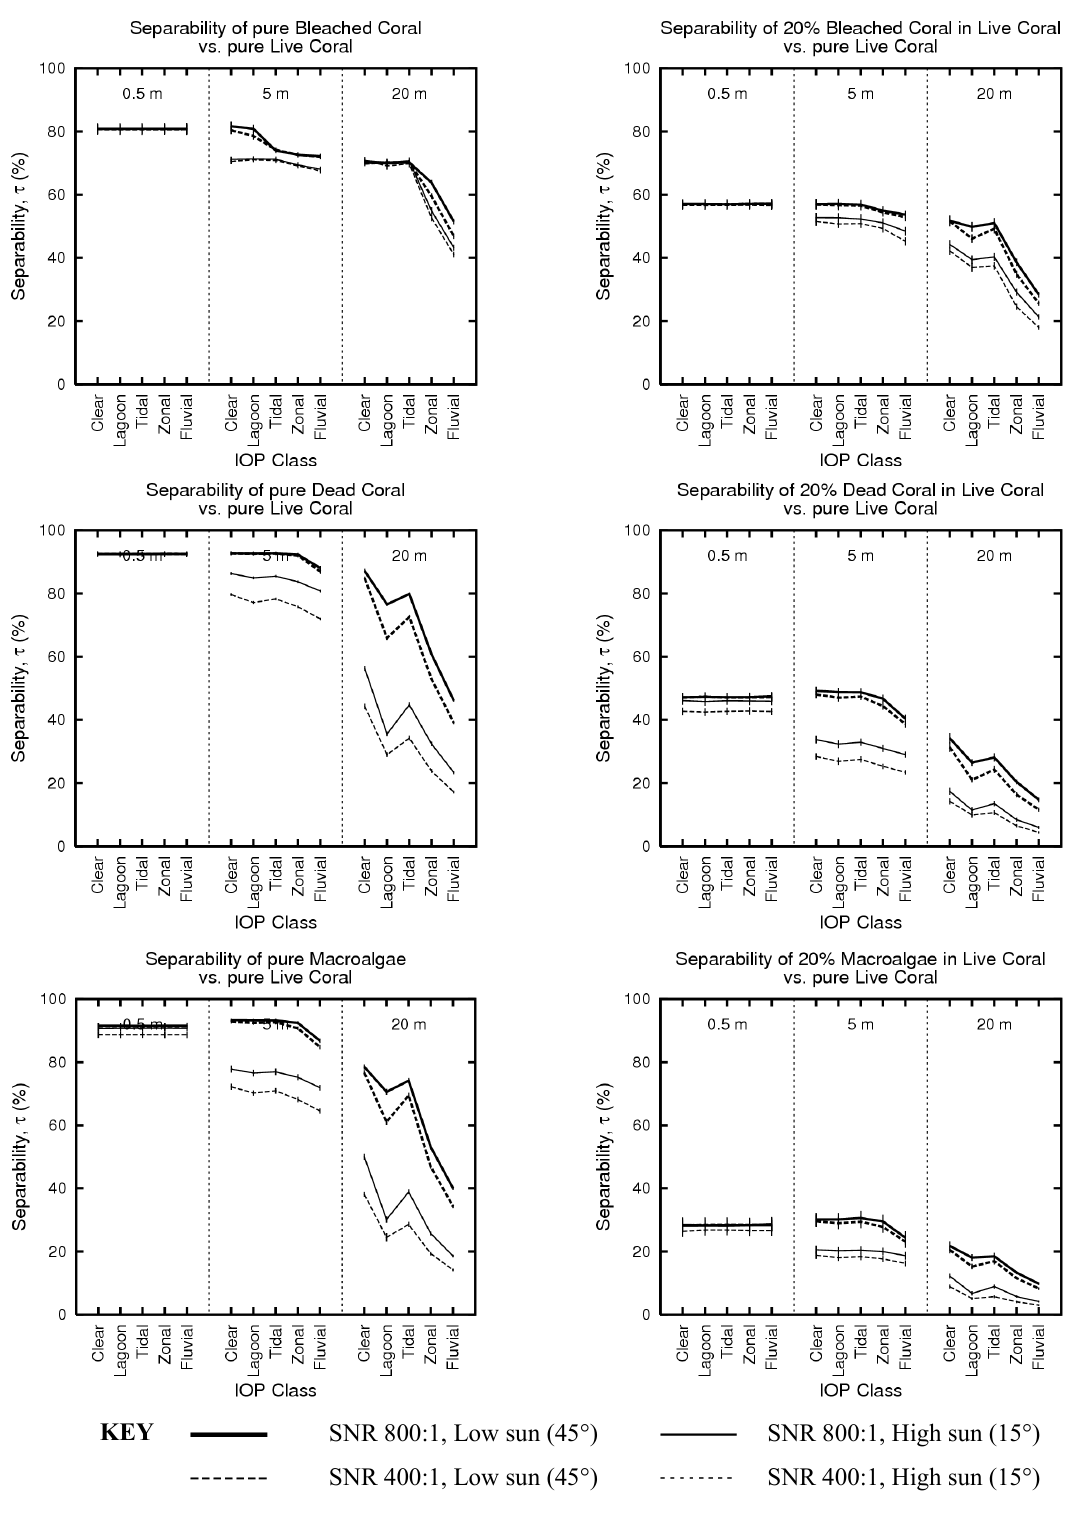
Figure 8. Specific-depth results for separability of Bleached Coral, Dead Coral and Macroalgae from Live Coral for pure cover proportions (left column) and for 0.2 proportion (20%) in Live Coral (right column). Results are for specific uniform